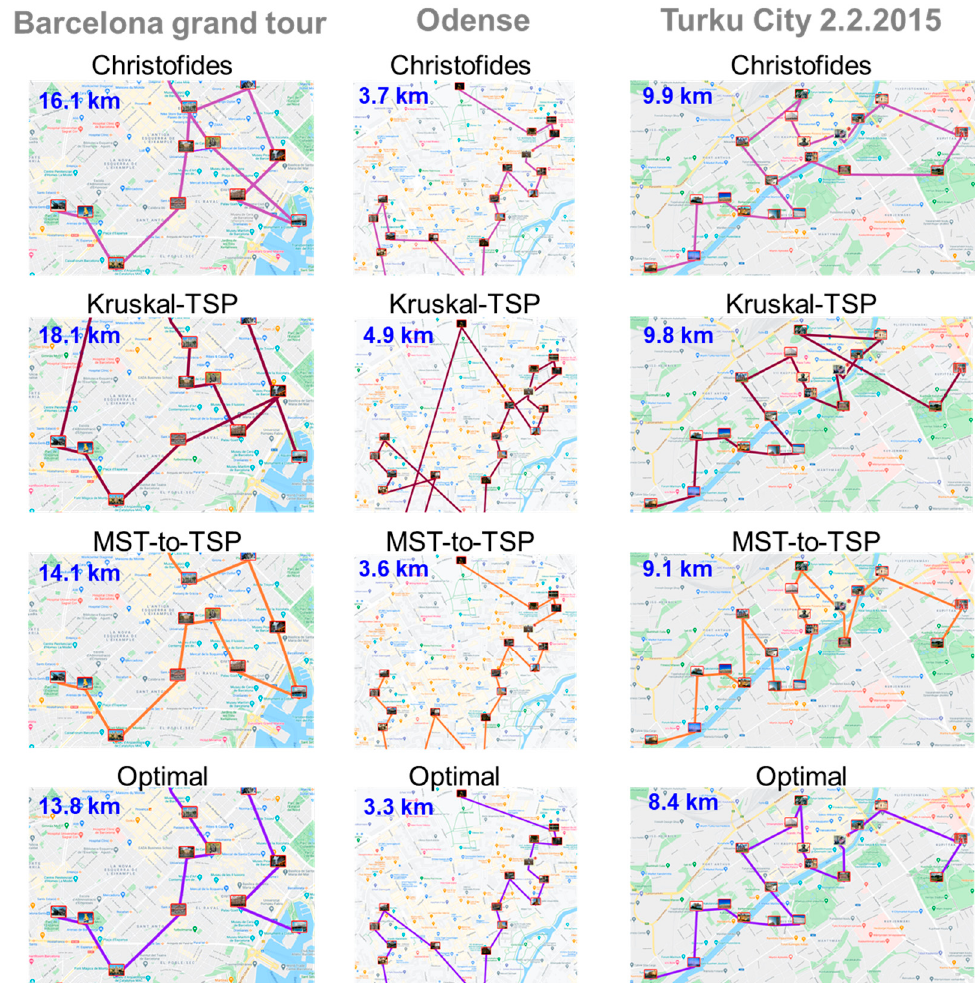
Figure 16. Examples of Christofides, Kruskal-TSP, and MST-to-TSP (greedy variant) with the three more challenging O-Mopsi games. Barcelona Grand Tour and Turku City 2.2.2015 have four branches while Odense has five. None of the algorithms finds the optimal solution.